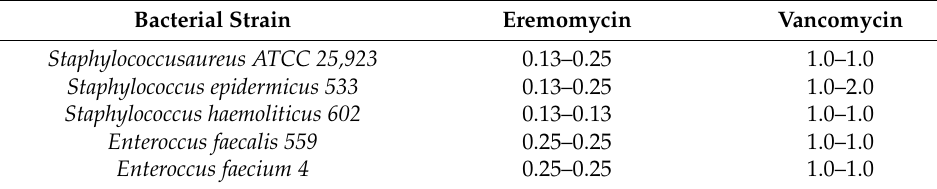
Table 1. MIC values ( µ g/mL) of eremomycin and vancomycin [5]. Bacterial